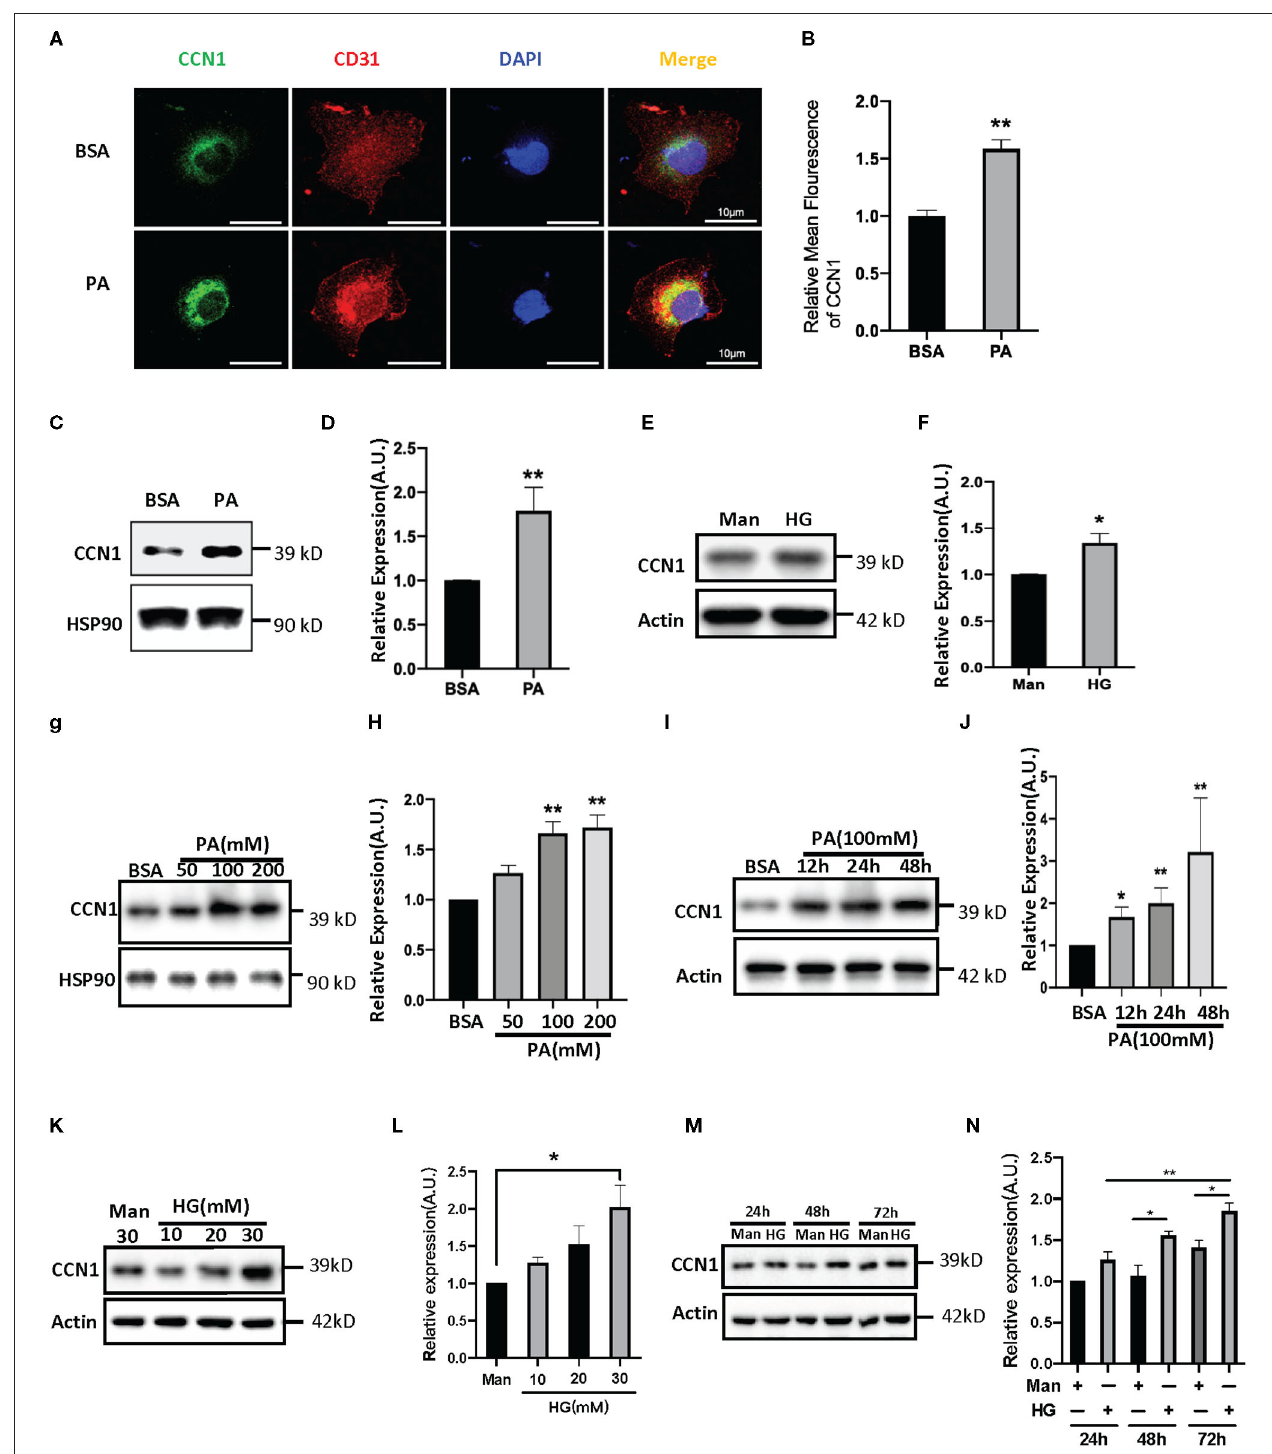
FIGURE 3 | Palmitic acid (PA) and high glucose (HG) levels induce CCN1expression in human retinal vascular endothelial cells (HRVECs). (A) Representative images and (B) quantification of CCN1 mean fluorescence in HRVECs treated with 100mM PA for 24h, scale bar = 10 µ m. (C,E) Western blot analysis and (D,F) densitometry quantification of CCN1 in HRVECs under 100mM PA or 30mM HG treatment, respectively. (G) Western blot analysis and (H) densitometry quantification of CCN1 in HRVECs under 50, 100, or 200mM PA for 24h. (I) Western blot analysis and (J) densitometry quantification of CCN1 in HRVECs under 100mM PA treatment for 12, 24, and 48h. (K) Western blot analysis and (L) densitometry quantification of CCN1 in HRVECs under 10, 20, or 30mM HG for 48h. (M) Western blot analysis and (N) densitometry quantification of CCN1 in HRVECs under 30mM HG treatment for 24, 48, and 72h. * p < 0.05, ** p < 0.01.